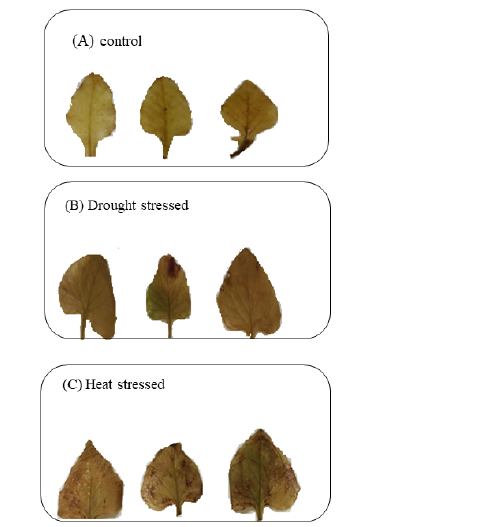
Figure 3. DAB-stained leaves of E. sonchifolia (3-month old). (A) control plants, (B) drought-stressed plants (1 week), and (C) heat-stressed plants (45 °C for 6 hours in a day).